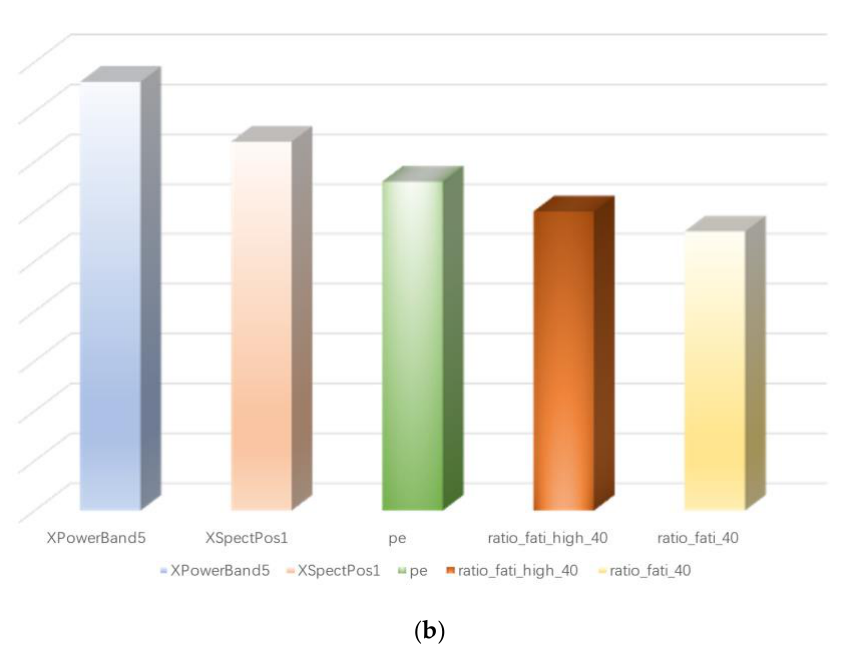
Figure 9. ( a ) The 5 selected features as a directed graphical. ( b ) Correlation ranking of the 5 selected features.